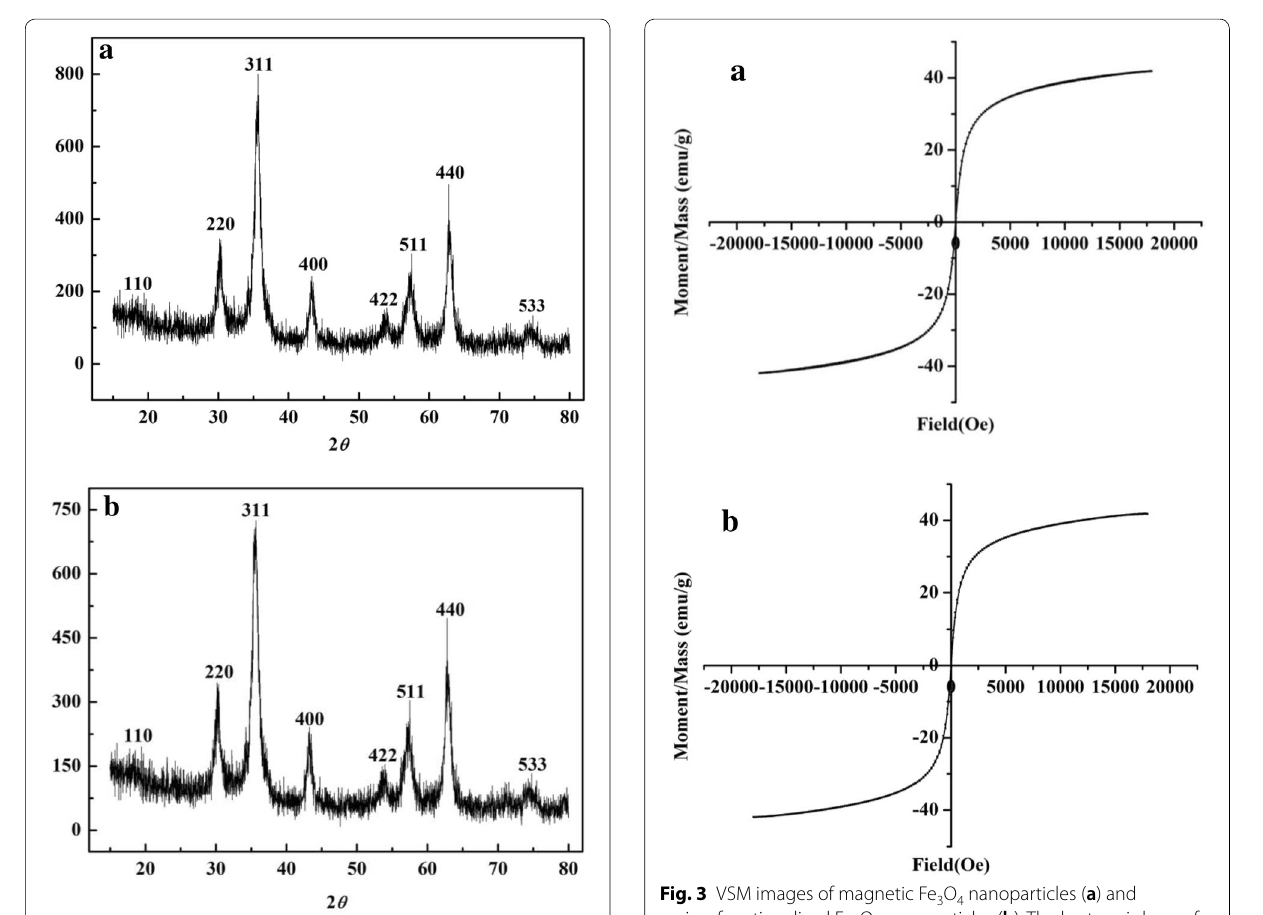
Fig. 2 X-ray diffraction patterns of magnetic Fe 3 O 4 nanoparticles ( a ) and amino-functionalized magnetic Fe 3 O 4 nanoparticles ( b )